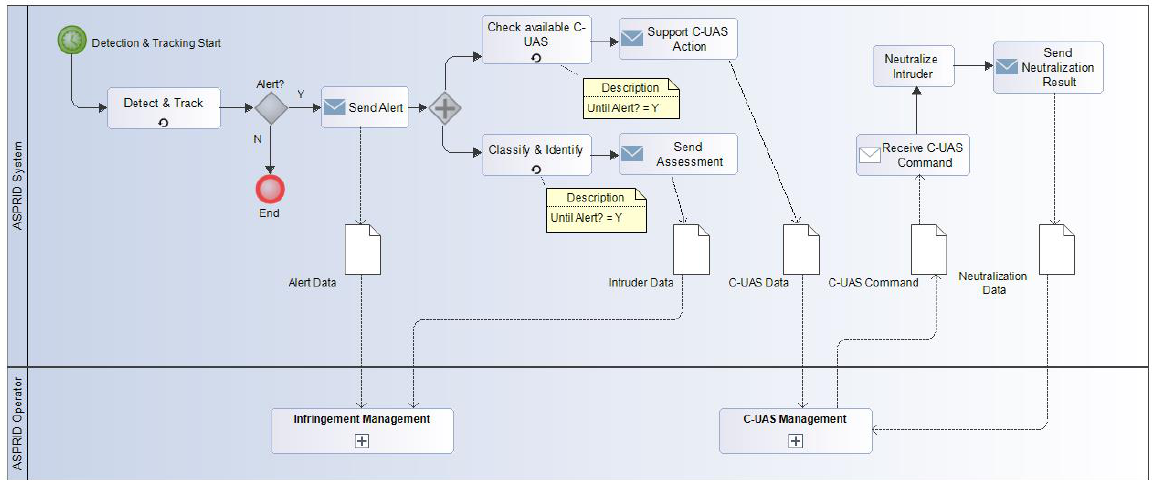
Figure 4. BPMN process diagram of ASPRID operational procedure: main process.